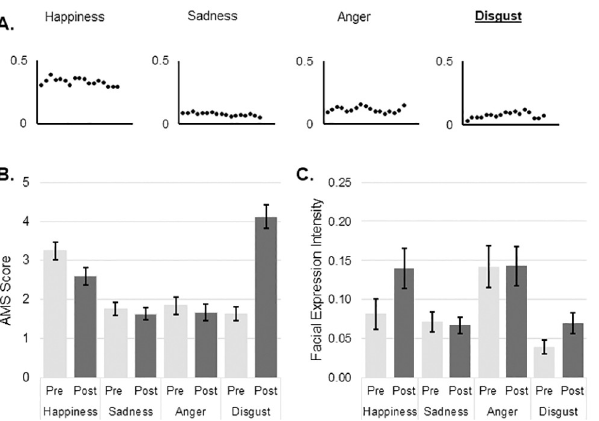
Fig 4. Disgust induction. A: Change in mean values of emotions during the course of video as measured by automated facial expression analysis; B: Mean and SE of subjective mood evaluation as measured by AMS; C: Mean and SE of objective mood evaluation as measured by automated facial expression analysis. AMS: Actual Mood State; SE: Standard Error.